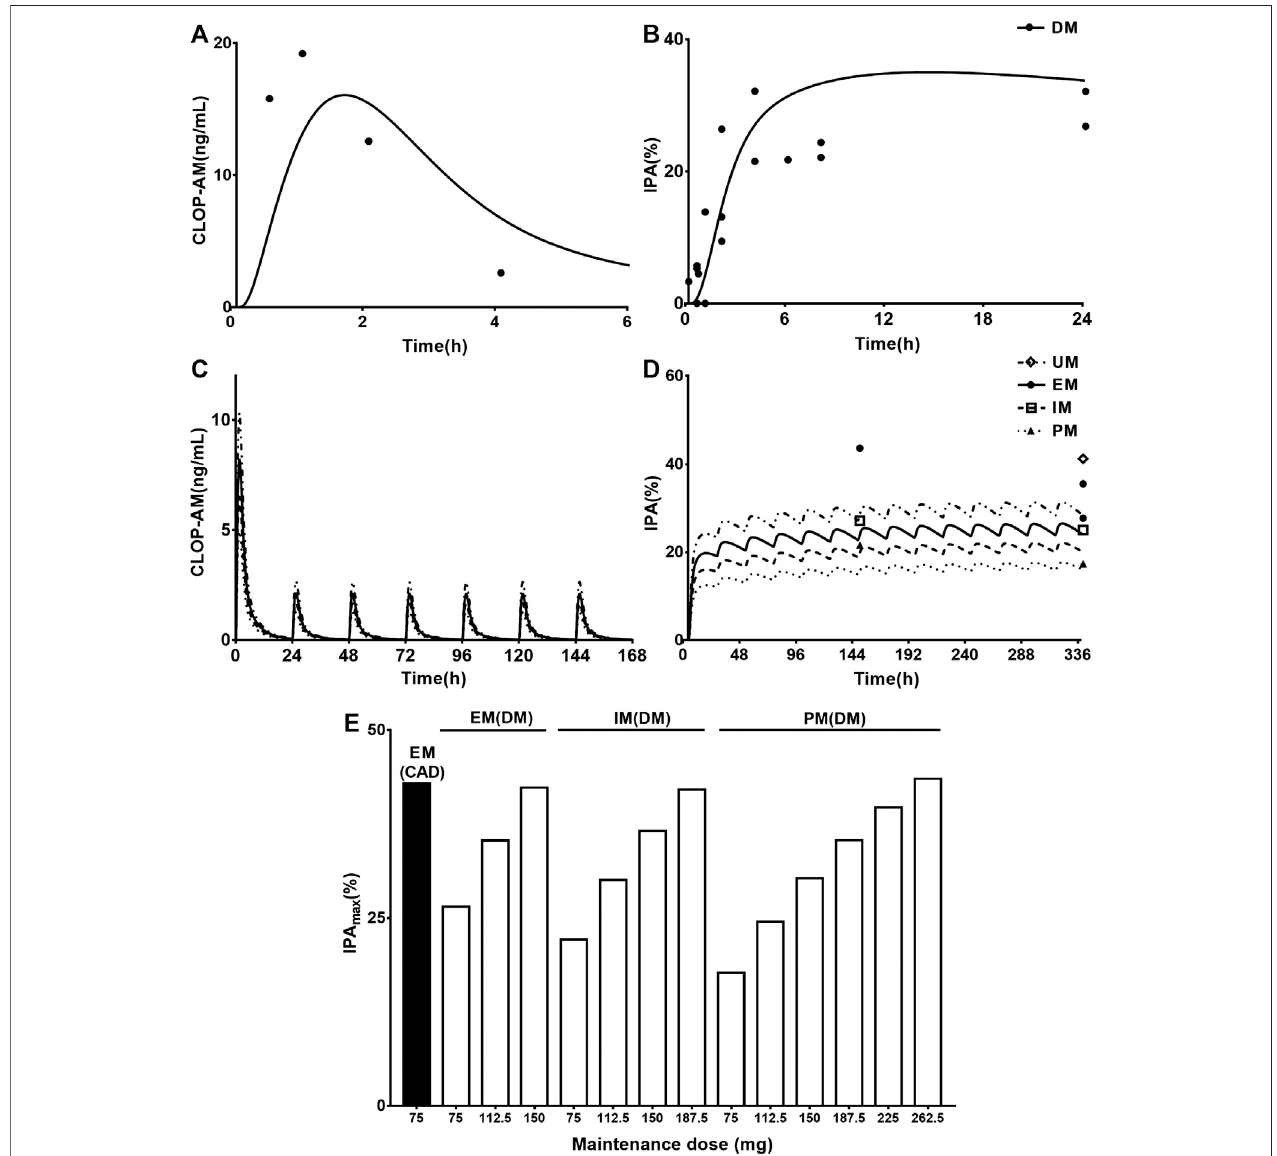
FIGURE5 | The predicted and observed pharmacokineticand pharmacodynamicpro fi les in CAD patients withDM. Plasma concentration-time (A) pro fi le and IPA (B) of CLOP-AM after 600 mg single dose to CAD patients with DM (without considering CYP2C19 phenotypes). The observations from Angiolillo (2011, n (cid:1) 34) (Angiolillo et al., 2011a), Angiolillo (2014, n (cid:1) 30) (Angiolillo et al., 2014), Clavijo ( n (cid:1) 21) (Clavijo et al., 2015) and Sweeny ( n (cid:1) 16) (Sweeny et al., 2017). The simulated plasma concentrations (C) of CLOP-AM and (D) IPA (%)-time pro fi le after 300 mg loading dose followed by 75 mg maintenance dose to CAD patient with DM carrying CYP2C19 phenotypes. The observations from Carreras (EM n (cid:1) 82, PM n (cid:1) 27) (Carreras et al., 2016), Liu (no data) (Liu et al., 2014), Oestreich (UM n (cid:1) 14, EM n (cid:1) 62,IM n (cid:1) 22)(Oestreichetal.,2014). (E) simulateddose-andCYP2C19phenotype-dependentIPAfollowing300 mgloadingdosefollowedbymaintenancedosein CAD patients with DM, CAD-EMs without DM served as control.